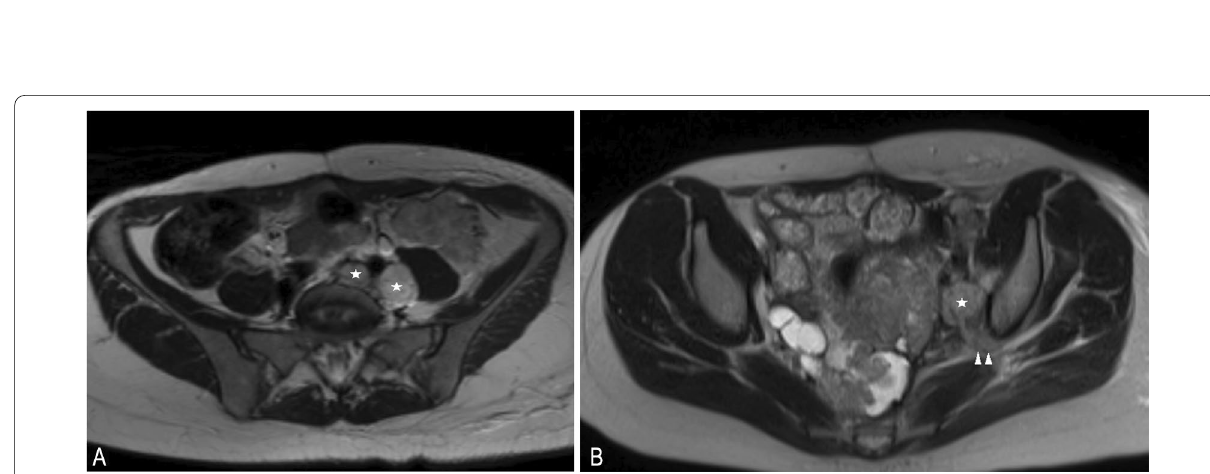
Fig. 20 a , b Two different patients with biphasic malignant peritoneal mesothelioma. MRI shows ( a ) retroperitoneal (*) nodes and ( b ) left pelvic side wall lymph node (*). Note the disease extension into the left sciatic notch ( b , arrow